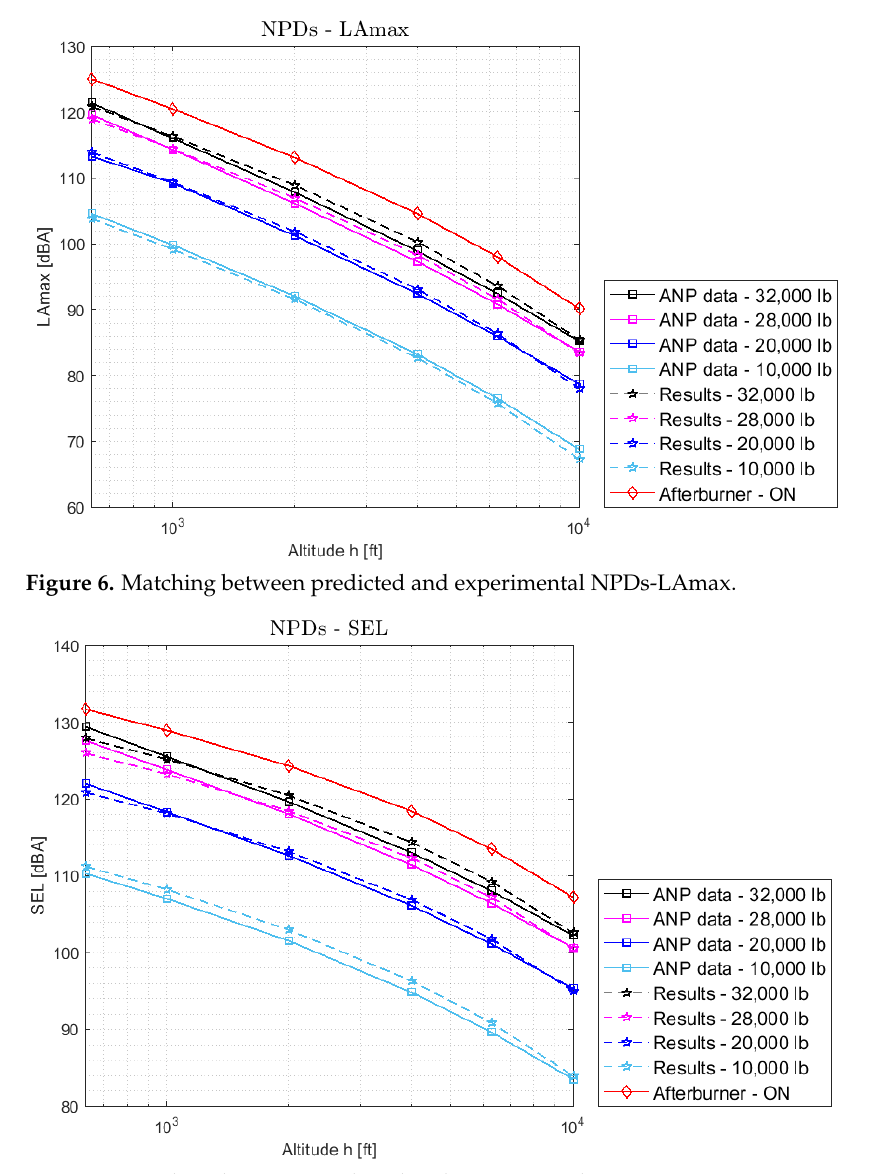
Figure 7. Matching between predicted and experimental